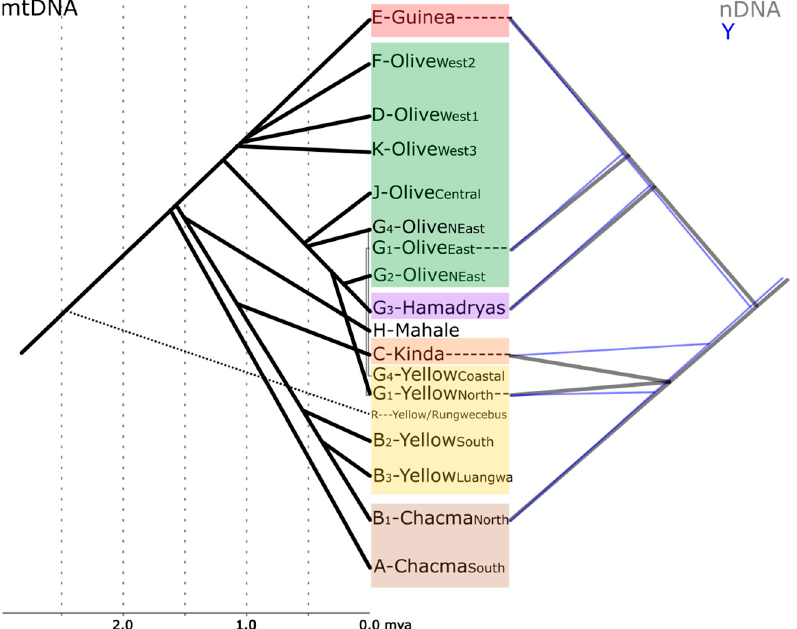
Figure 2. Sketch showing the phylogenetic relationships between baboons based on mtDNA [34,35,37,46–48], Y-chromosomes [43], and whole nuclear genomes [18]. Minor subclades are omitted for clarity. Divergence time estimates for Y-chromosomal data do not exist yet [43] and are inconclusive for nDNA [18] and are, therefore, not shown.